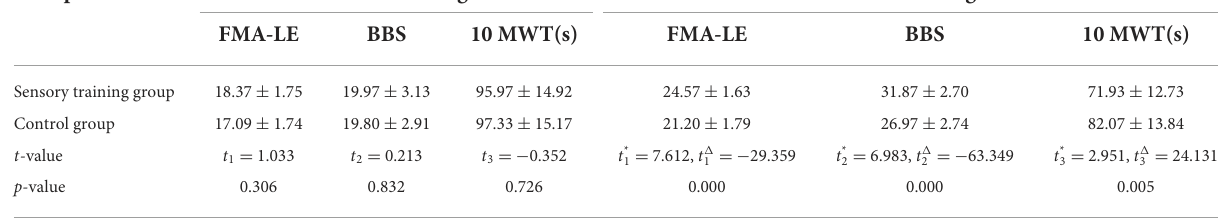
TABLE 3 Lower extremity motor function assessment. Group Before training After